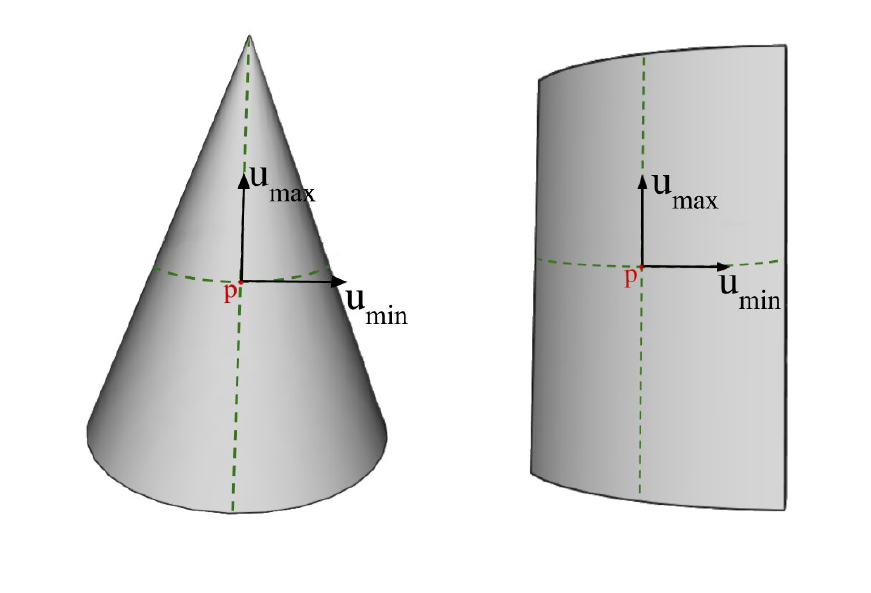
Figure 10. Example of maximum and minimum curvature directions in a generic point p